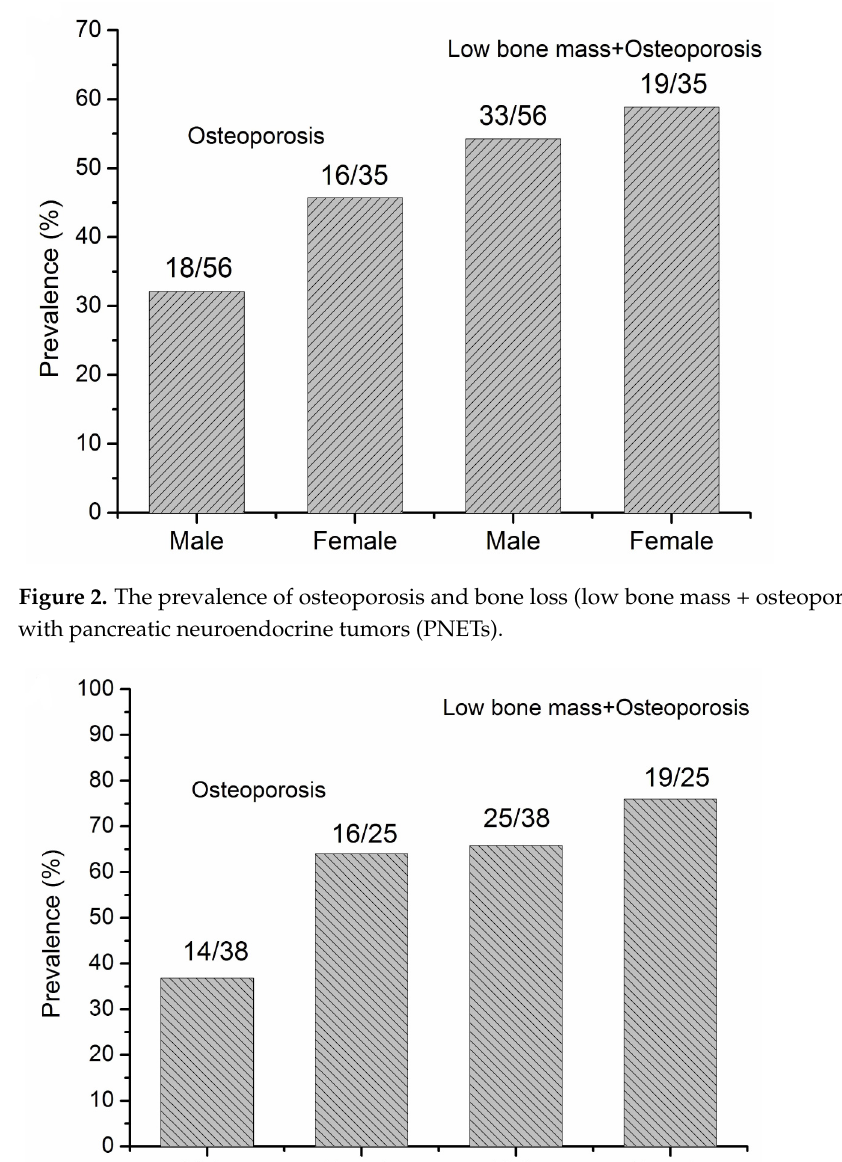
Table 2. Associations between variables and osteoporosis and low bone mass in pancreatic neuroendocrine tumors (PNETs).